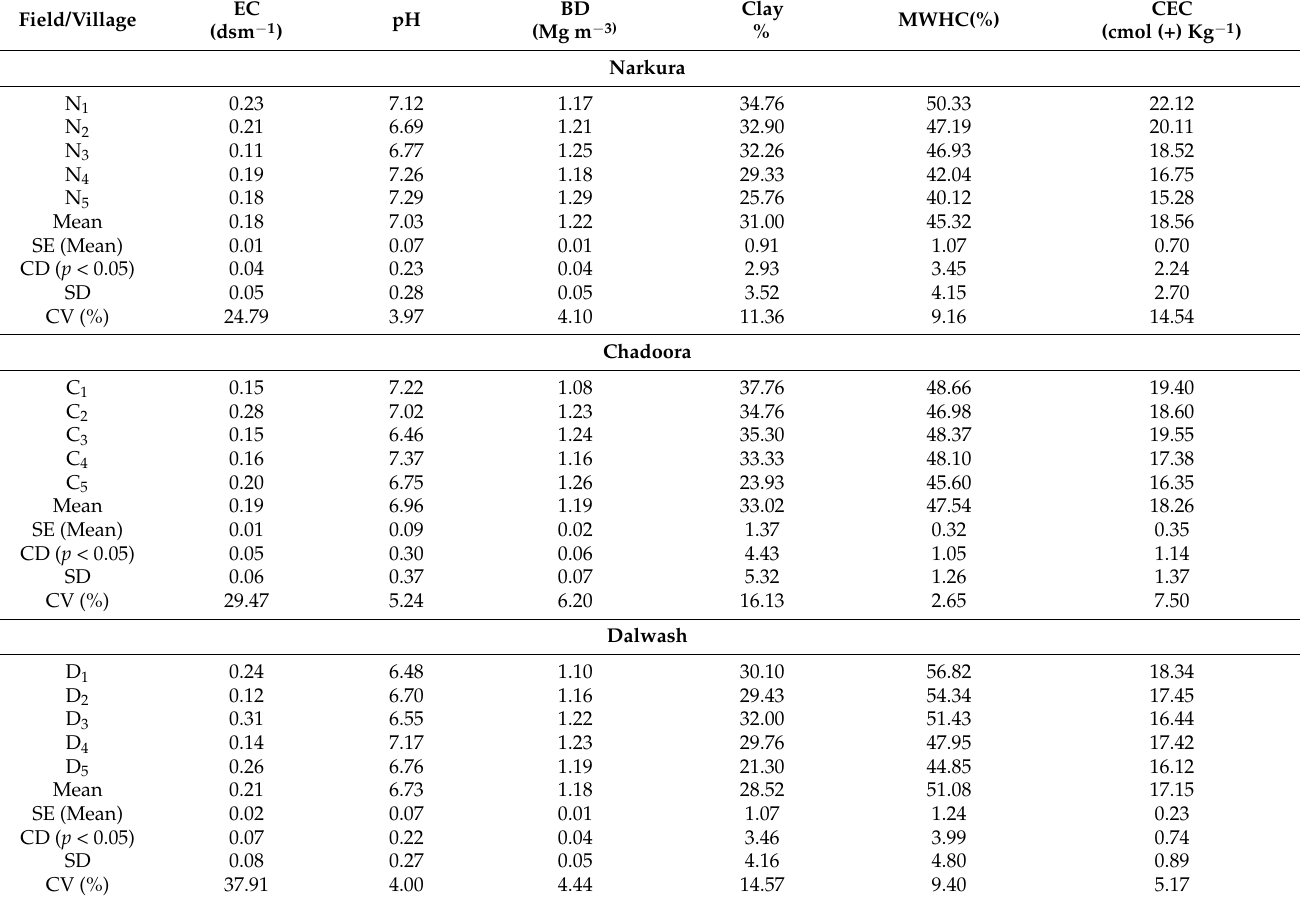
Table 2. Physico-chemical properties of soils in the villages.